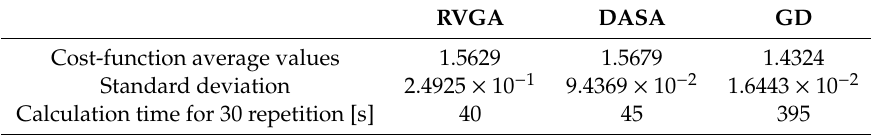
Table 8. Results of the comparison among the applied algorithms for the TA.